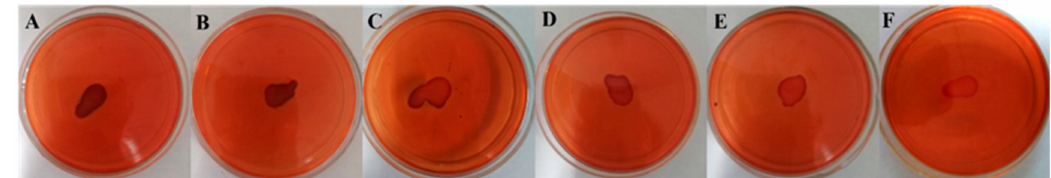
Figure 4. The e ff ects of thymol on the production of polysaccharide intracellular adhesin (PIA) by TCH1516 biofilms. Plates shown in ( A – F ) were treated with 0, 8, 16, 32, 64 and 128 µ g / mL thymol, respectively.